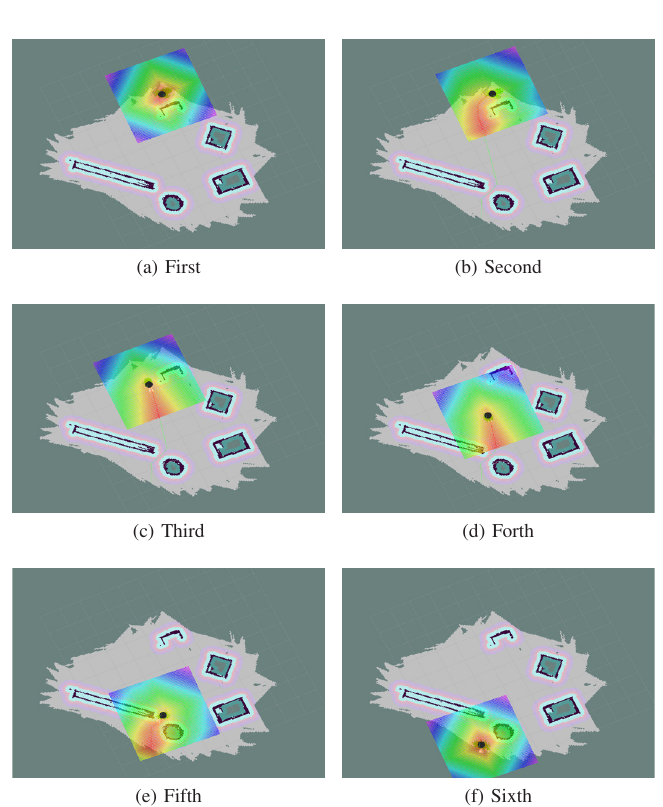
Fig. 7: Autonomous